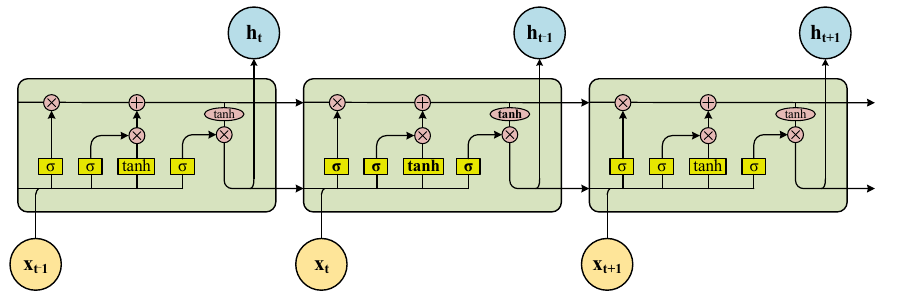
Figure 1. LSTM neural network structure